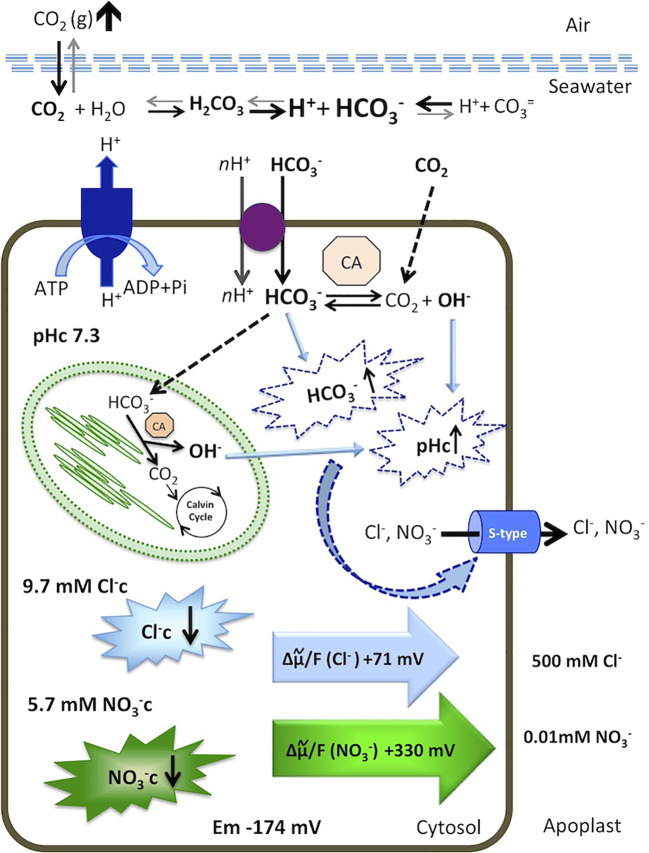
Model for cytosolic NO3− and Cl− responses to an increase of dissolved inorganic carbon in the marine angiosperm Posidonia oceanica leaf cells. Elevated atmospheric CO2 level increases total dissolved inorganic carbon, shifting the equilibrium in favor of HCO3− in the seawater. The HCO3− is taken up by an H+-symport and dehydrated in the cytosol or transported to the chloroplast serving as inorganic carbon source for photosynthesis. Internal dehydration, catalyzed by the carbonic anhydrases (CA) renders CO2, consumed by the Calvin Cycle, and OH- ions that increase cytosolic pH (pHc). Excess of cytosolic HCO3− and elevated pHc activates S-type anion channels, through which Cl− and NO3− leave the cells by an outwardly directed motive force of +71 mV and +330 mV, respectively. Consequently, the cytosolic concentrations of both anions decrease. Membrane potential, ion concentrations, calculations, and discussion are included in the text.